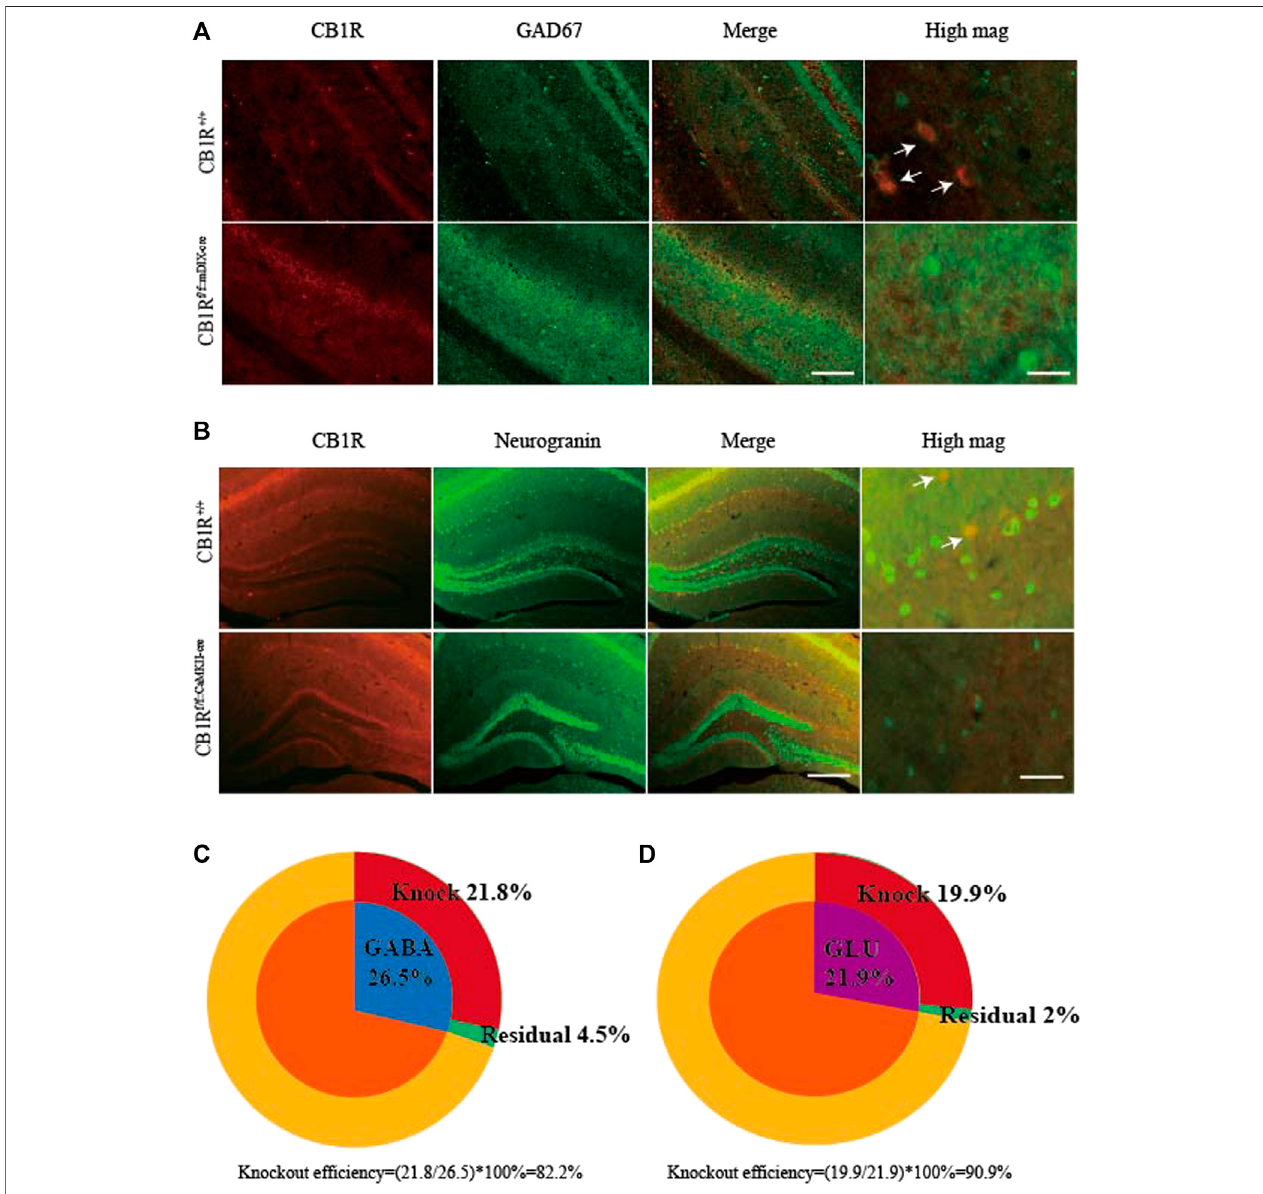
FIGURE 4 | Speci fi c knockout of the CB1R in GABAergic and glutamatergic neurons in the vHPC. (A) After rAAV-mDIX-cre-WPRE-pA viruses were injected into bilateral vHPC of CB1R- fl ox mice, immuno fl uorescence images showed CB1R (red) co-expressed with GAD67 (labeled GABAergic neurons, green) in the vHPC. Scale bar for merge images, 200 μ m. Scale bar for high magni fi cation images (high mag), 40 μ m. (B) After rAAV-CaMKII-cre-WPRE-pA viruses were injected into bilateral vHPC of CB1R- fl ox mice, immuno fl uorescence images showed CB1R (red) co-expressed with neurogranin (a marker of glutamatergic neurons, green) in the vHPC.Scalebar formerge images, 100 μ m. Scalebar forhighmagni fi cation images (highmag), 20 μ m. (C) Summarydatashow thepercentage ofGABAergicneurons whoseCB1receptorswereknockedout(red). (D) SummarydatashowthepercentageofglutamatergicneuronswhoseCB1receptorswereknockedout(red).Dataare expressed as the means ± SEM ( n = 3 mice in each